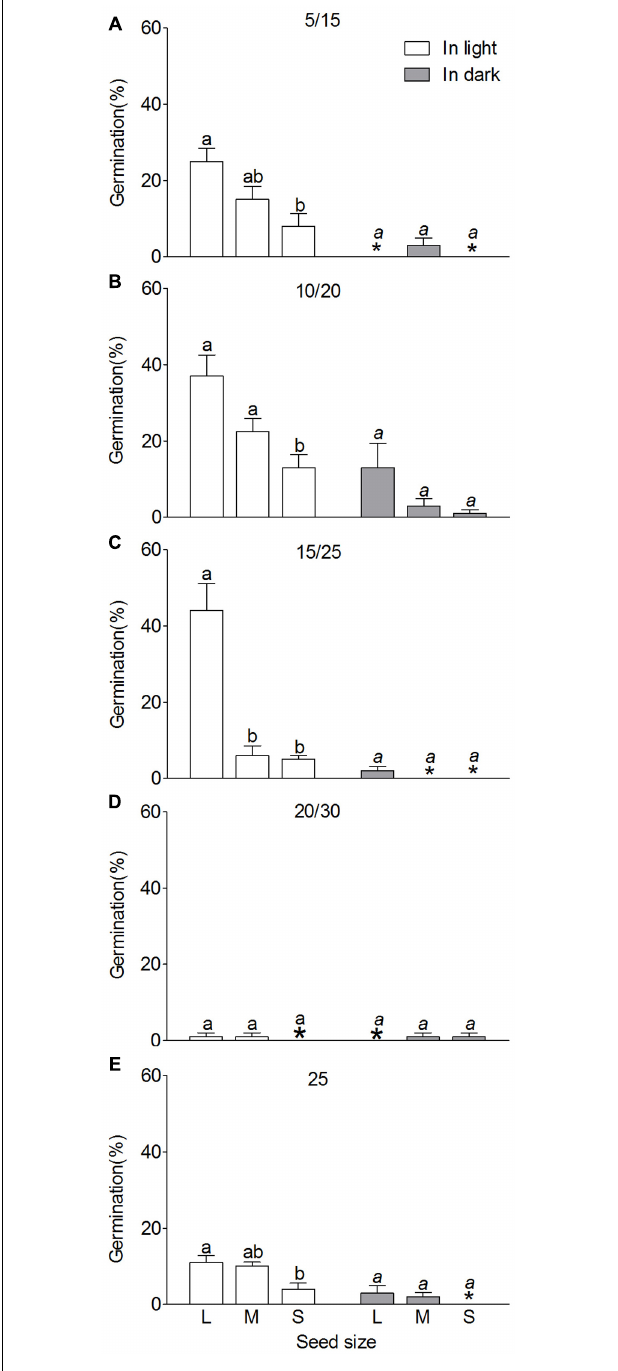
FIGURE 10 | Effect of night/day temperature variation (N/DTV) on germination of heteromorphic seeds of S. ferganica. Seeds collected in 2014 were used in the test and seed vigor was lower at the moment. (A–E) Heteromorphic seeds incubated at different N/DTV. 5/15, 10/20, 15/25, 20/30, and 25: 5/15 represents 5 ◦ C in dark for 12 h and then 15 ◦ C in light for 12 h, and the same meaning for 10/20, 15/25, 20/30; 25 represents 25 ◦ C in dark for 12 h then in light for 12 h. ∗ represents the value of zero. L, M, S: large, middle, small seed. Bars with different lowercase letters indicate significant differences ( P < 0.05) according to the Tukey’s test. Values are means ± SE of four replicates.